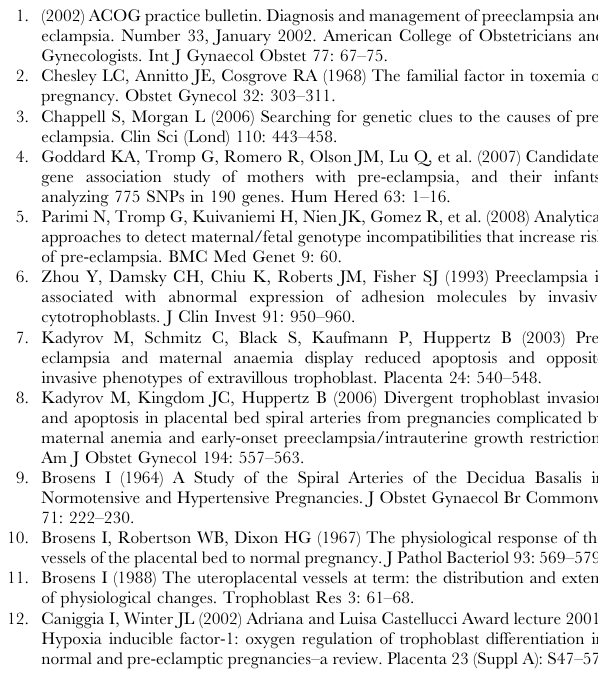
Table S1 COMT single SNP analysis for maternal and fetal samples with and without preeclampsia. Table S2 COMT pair-wise SNP linkage disequilibrium analysis for maternal and fetal